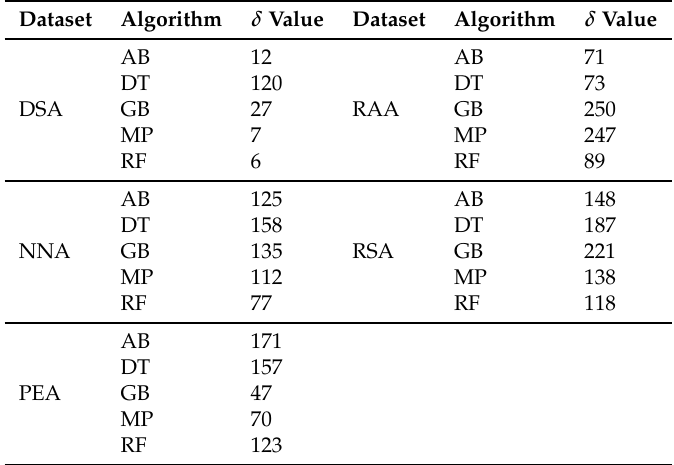
Table 11. NSL-KDD dataset—optimal δ value detection.